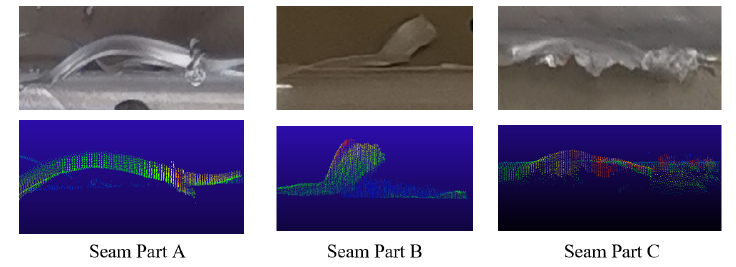
Figure 15. Weld seam feature result.